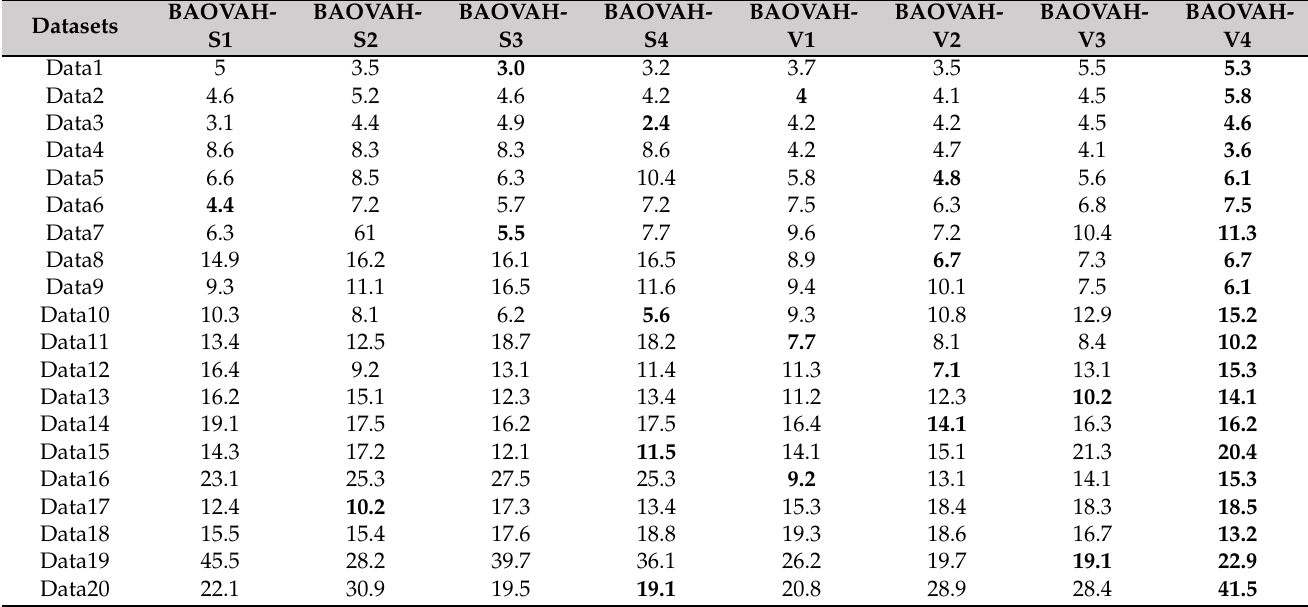
Table 3. Comparison of proposed BAVOA methods based on S-shaped and V-shaped based on the criterion of the average number of